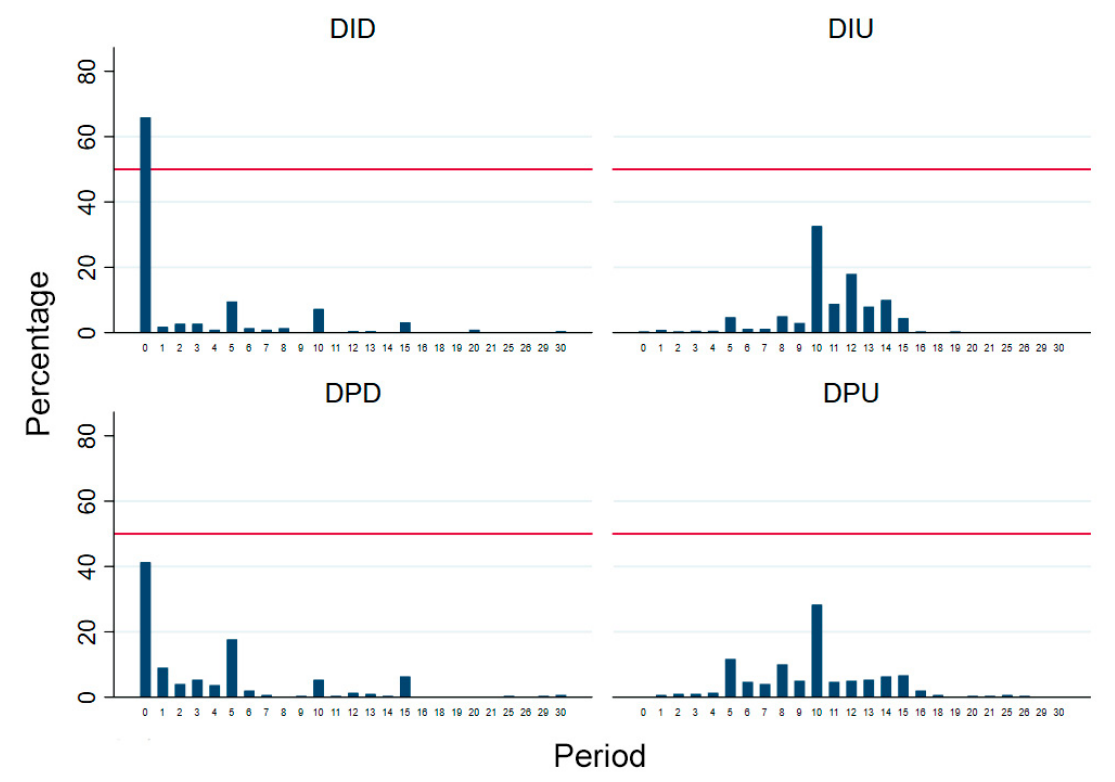
Figure 3. Percentage of offer values in four treatments. Note: The reference line represents 50%. DID represents the dishonesty-inducing dictator game; DIU represents the dishonesty-inducing ultimatum game; DPD represents the dishonesty-proof dictator game; and DPU represents the dishonesty-proof ultimatum game.